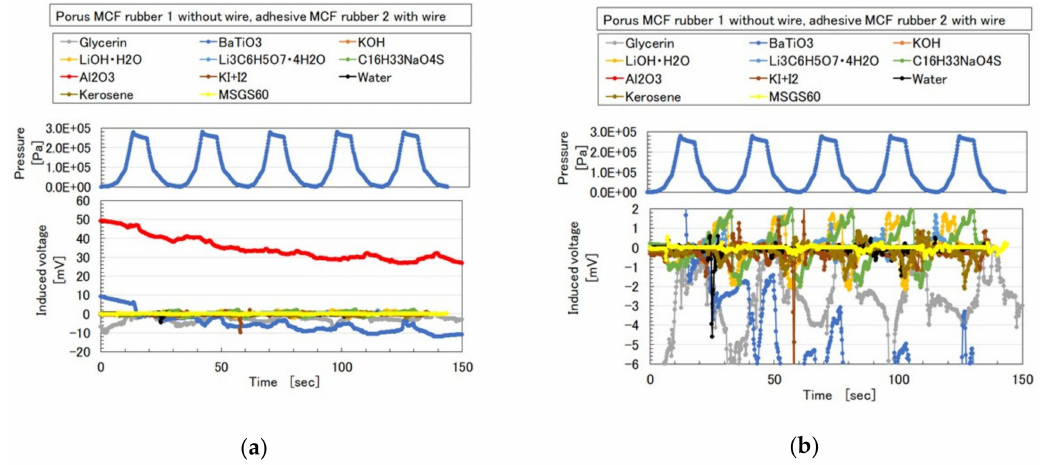
Figure 23. Induced voltage of MCF rubber sensor to repeated pressure by the production process of Figure 21: ( a ) zooming out of ( b ); ( b ) zooming in from ( a